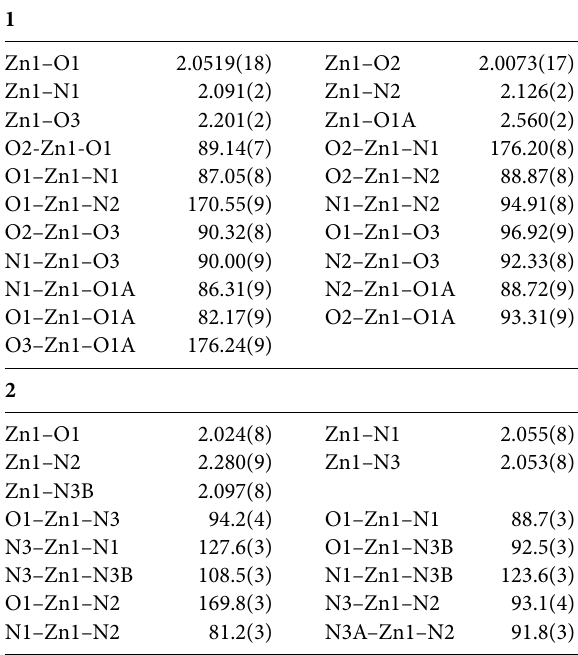
Table 2. Selected bond lengths (Å) and angles (º) for the